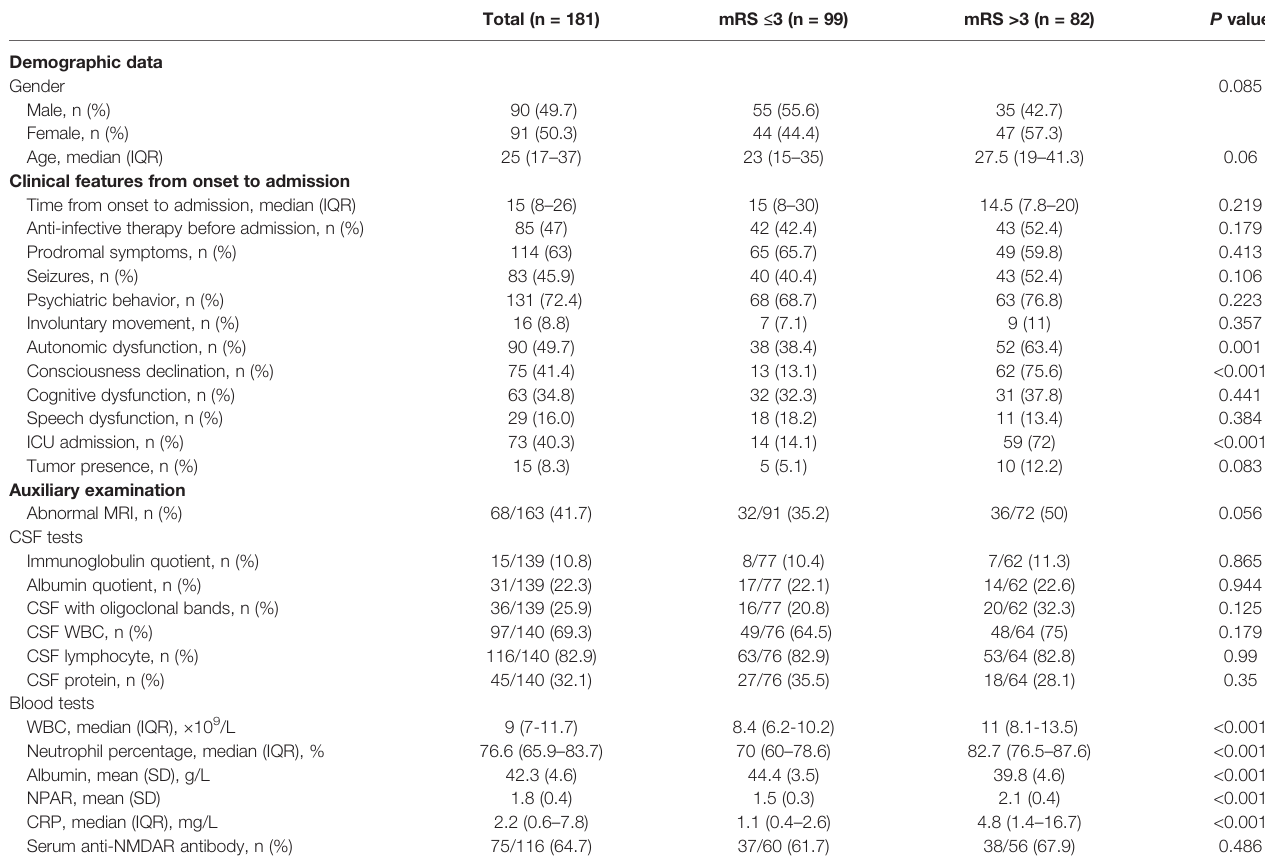
TABLE 1 | Comparison of clinical data of anti-MNDAR encephalitis with different severity at